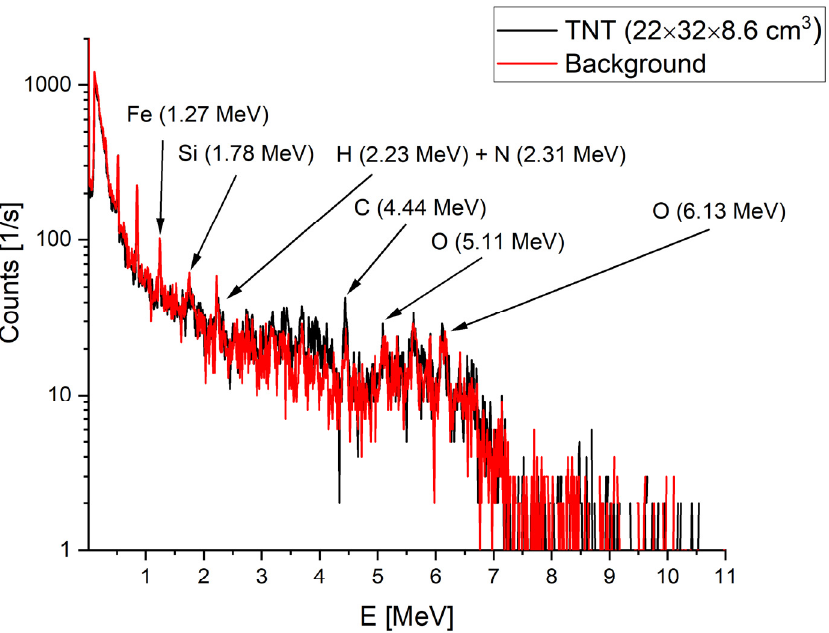
Figure 5. Simulated gamma ray energy deposition distribution simulated for background (red curve) and TNT mine (black). The sensor was placed 2 cm above the TNT.